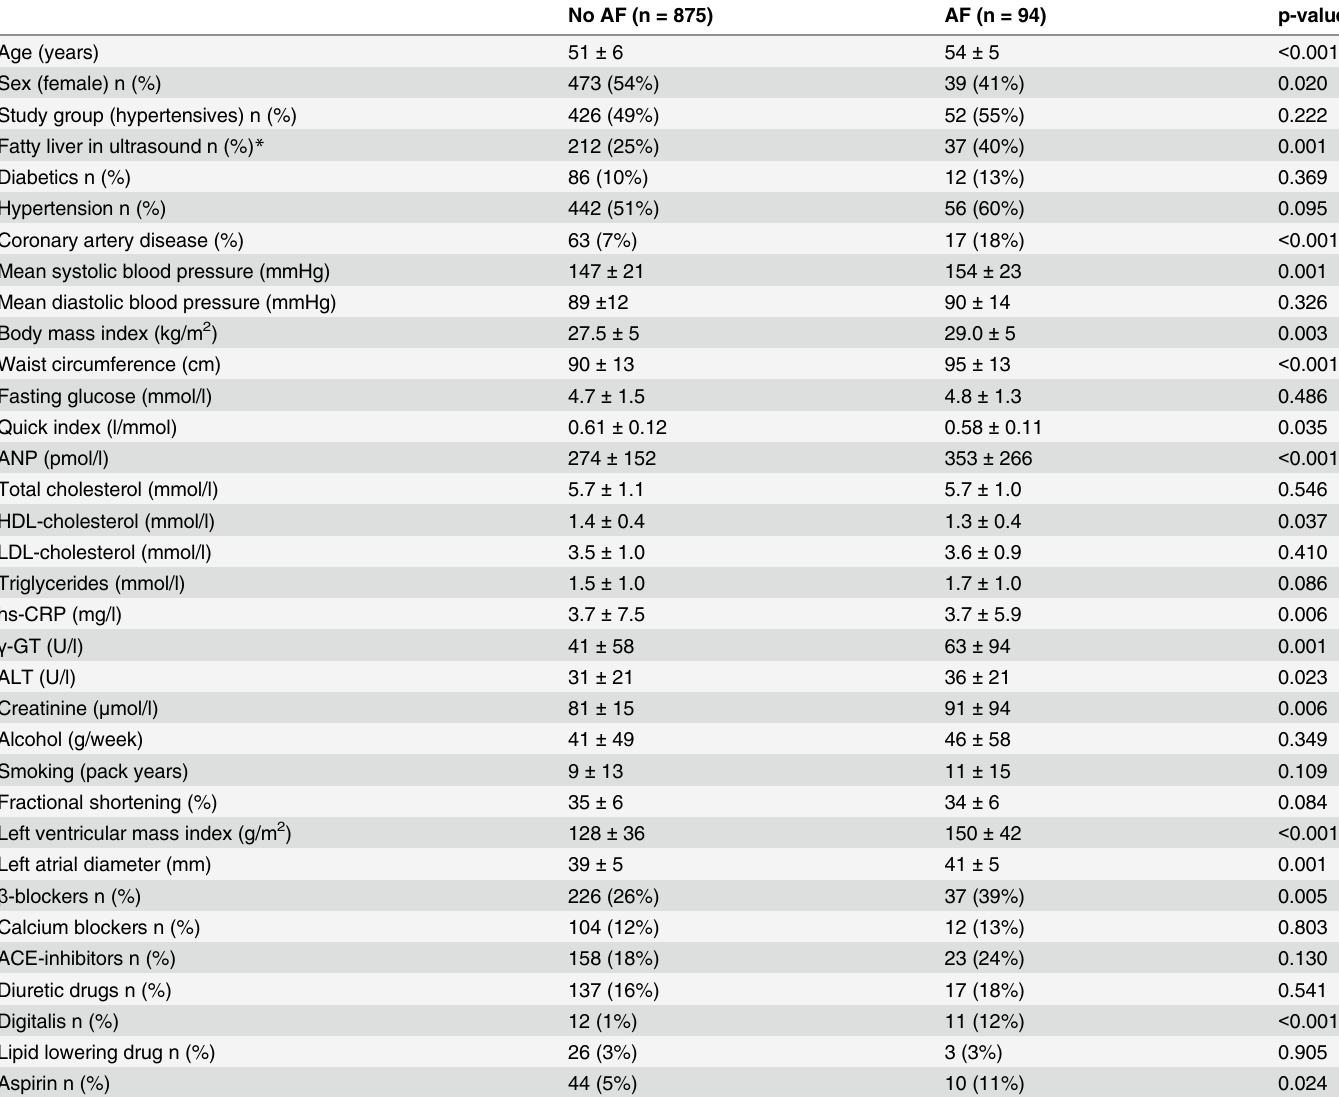
Table 2. Baseline characteristics in the subjects (n = 969) with and without atrial fibrillation (AF) in the